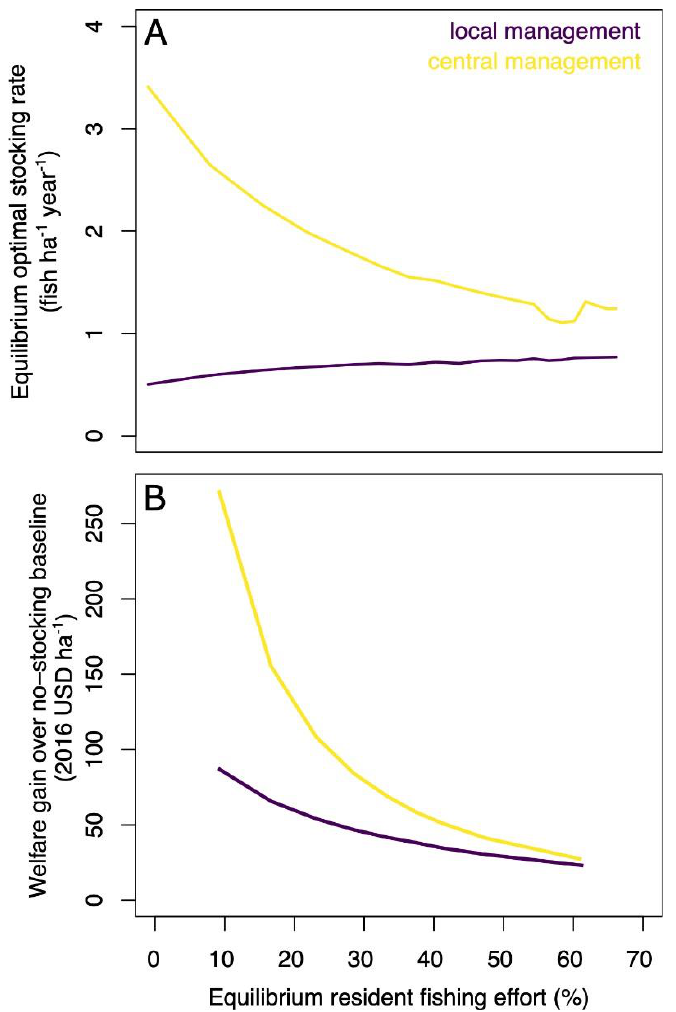
Figure A5.2. (A) Optimal stocking rate and (B) welfare gain (time discounted net benefits) from stocking relative to a no-stocking baseline, under local management by a collective action organization of lakeshore residents or centralized management by a government agency. The optimal investment and the resulting welfare gain depend on the proportion of total equilibrium angling effort that is comprised of resident anglers